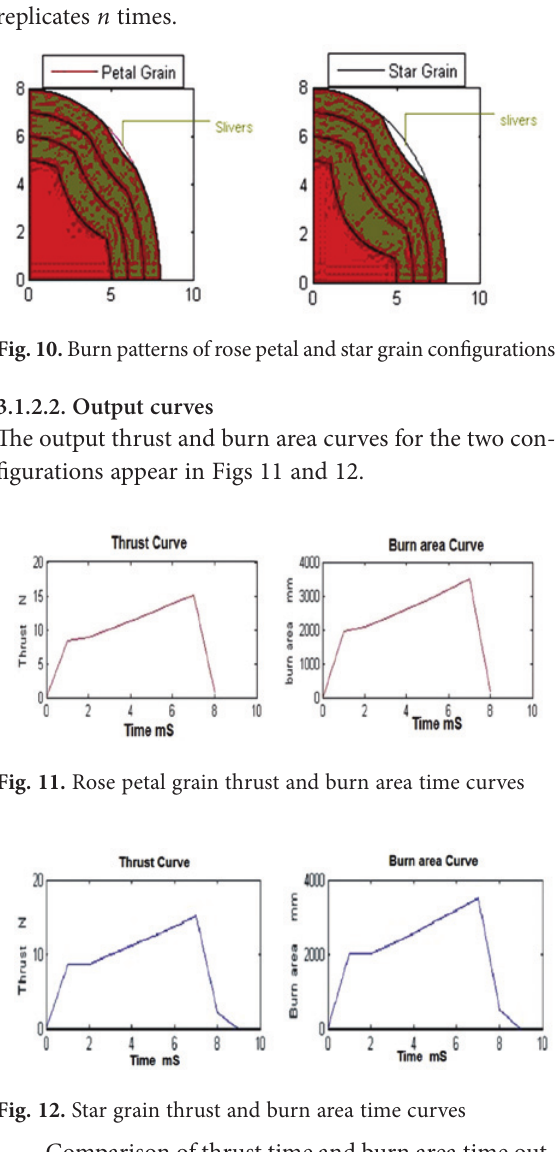
Fig. 13. Burn patterns of petal and star grain